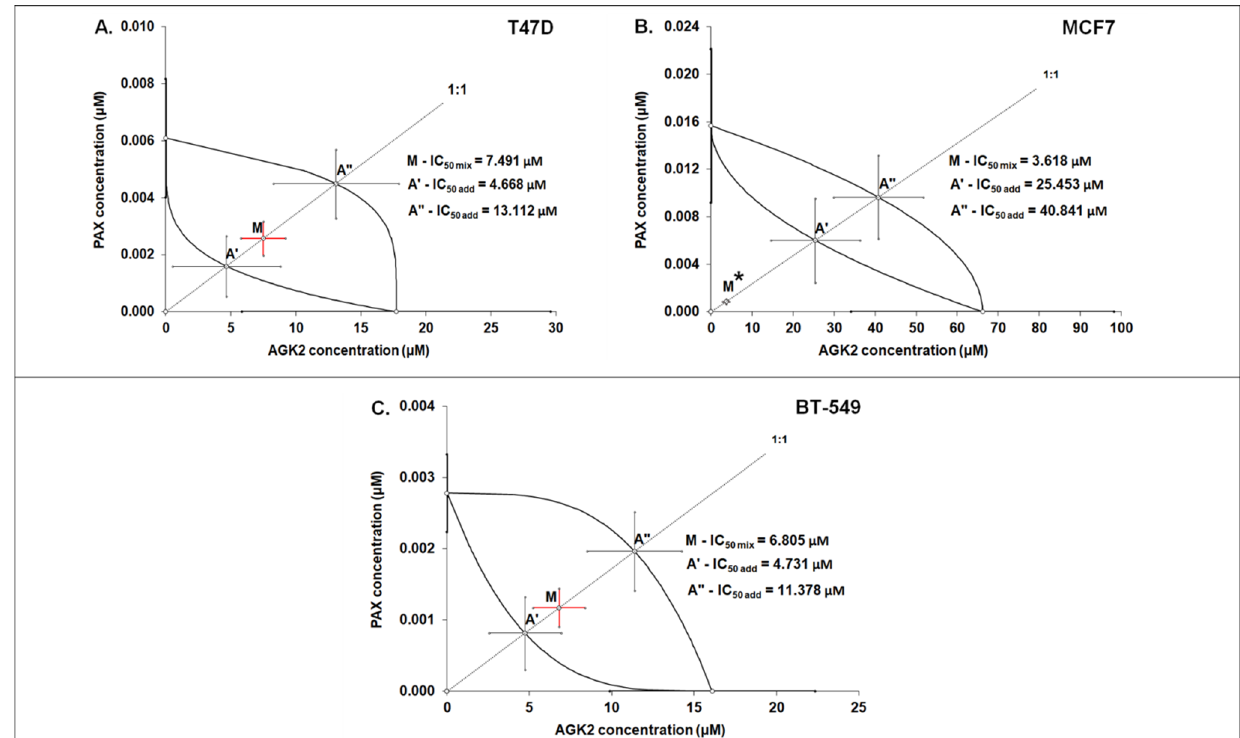
Figure 11. Isobolographic analysis of PAX and AGK2 for nonparallel CECs. Isobolograms illustrate additive and synergistic interactions between PAX and AGK2 in the T47D ( A ), MCF7 ( B ) and BT- 549 ( C ) cells measured using the MTT assay. The IC 50 values for PAX and AGK2 are plotted on the X- and Y-axes. The solid lines on the X- and Y-axes represent the SEM for the IC 50 values for the studied drugs administered alone. The lower and upper isoboles of additivity represent the curves connecting the IC 50 values for PAX and AGK2 administered alone. The line starting from the begin- ning of the Cartesian plot system corresponds to the constant ratio combination of 1:1. The points A’ and A” depict the theoretically calculated IC 50 add values for both the lower and upper isoboles of additivity. Point M represents the IC 50 mix value for the total concentration of the mixture expressed as proportions of PAX and AGK2 that produced a 50% antiproliferative effect (50% isobole) in the T47D, MCF7 and BT-549 cells measured using the MTT assay. On the graph, the SEM values are presented as horizontal and vertical error bars for every IC 50 value. The IC 50 mix value for BC cell line MCF7 is placed significantly below point A’, indicating a supra-additive (synergistic, Student’s t - test with Welch’s correction, * p < 0.05) interaction between PAX and AGK2. In contrast, the IC 50 mix values for the T47D and BT-549 BC cells are placed close to point A’, indicating an additive interac- tion between PAX and AGK2 in the T47D and BT-549 cells.